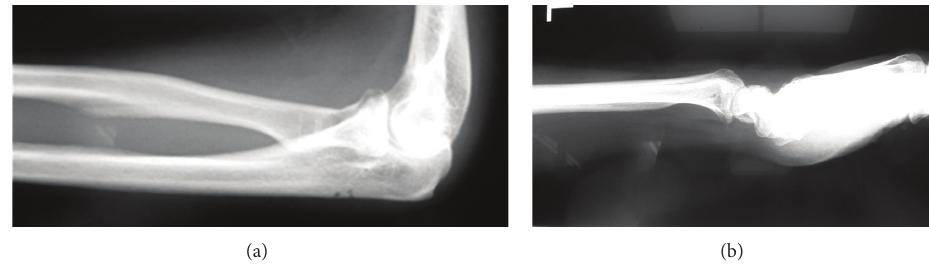
Figure 5: One year after the operation, proximal and distal radioulnar joint was in normal position.